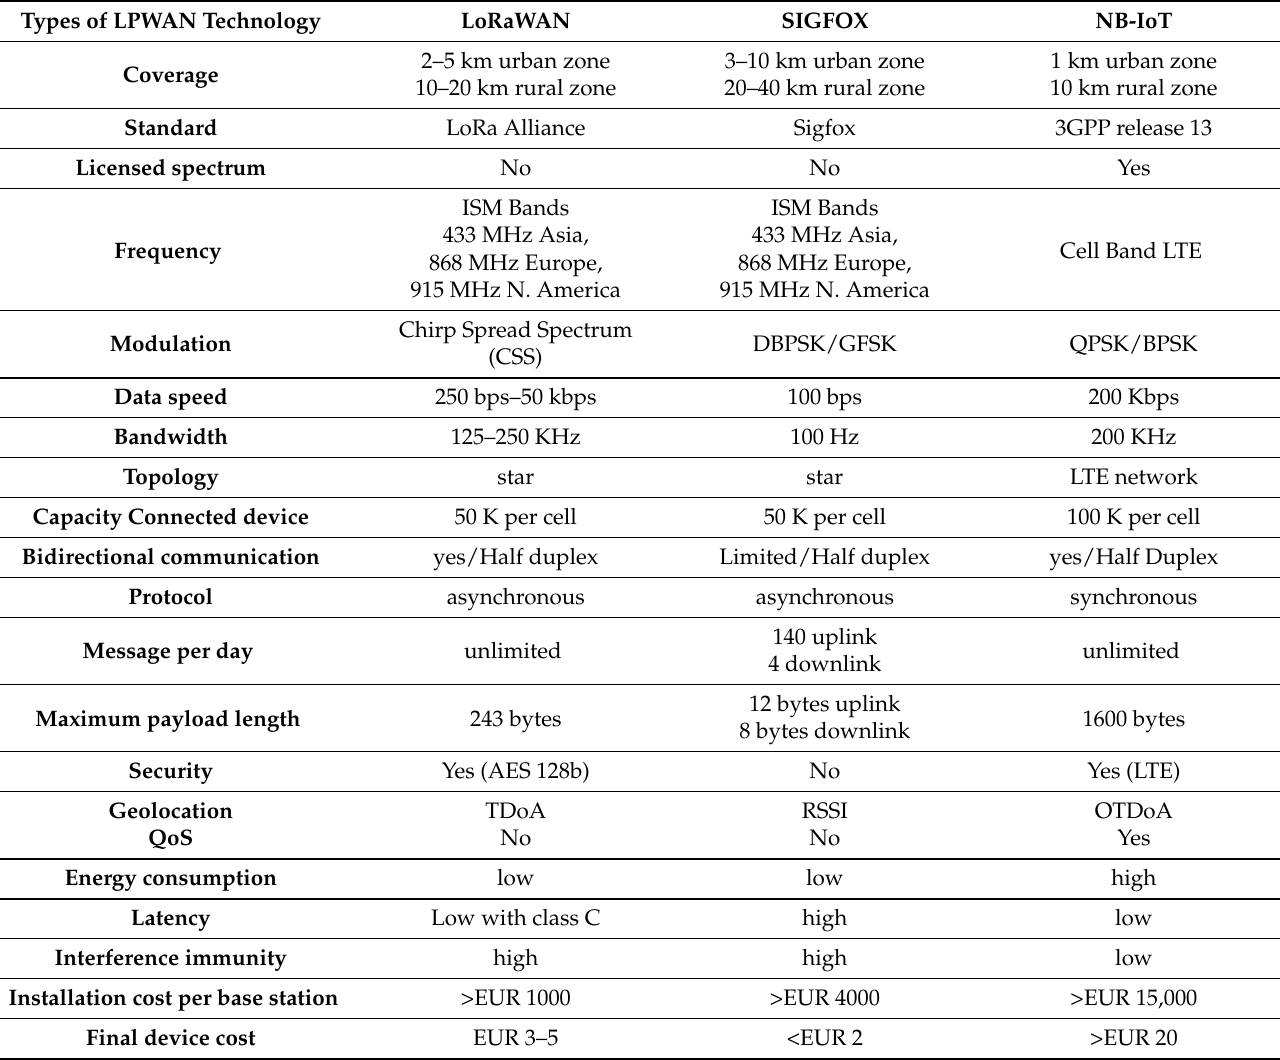
Table 1. Comparative chart of the three main Low-Power Wide-Area Networks (LPWANs) technologies. Types of LPWAN